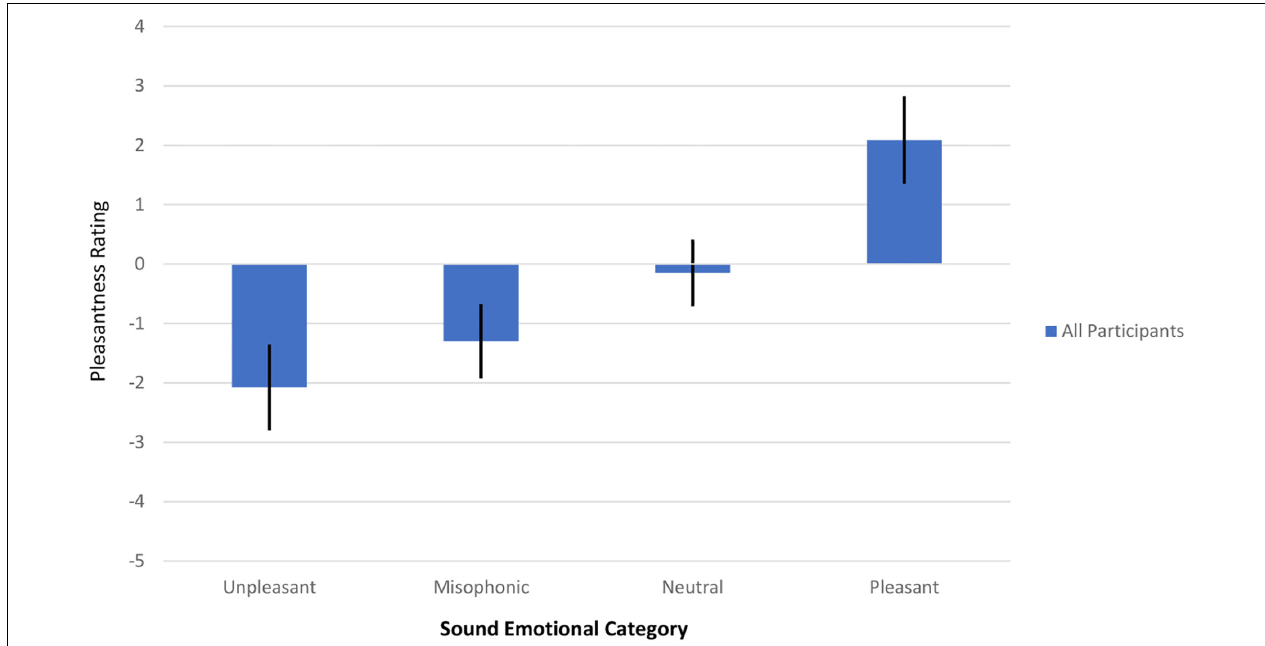
FIGURE 1 | Mean pleasantness rating versus the sound emotional category for all participants in Experiment 1. A 95% confidence interval ( t -test) is shown, represented by a thick black line. All four emotional categories are shown, in ascending order of average pleasantness (unpleasant, misophonic, neutral, and